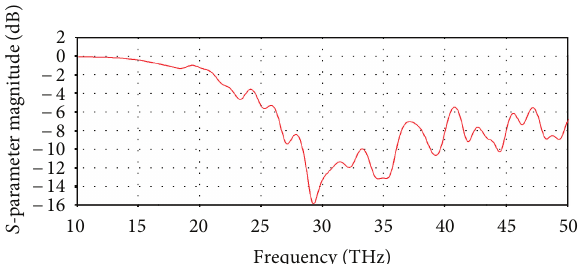
Figure 6: Input reflection coefficient of bowtie antenna.